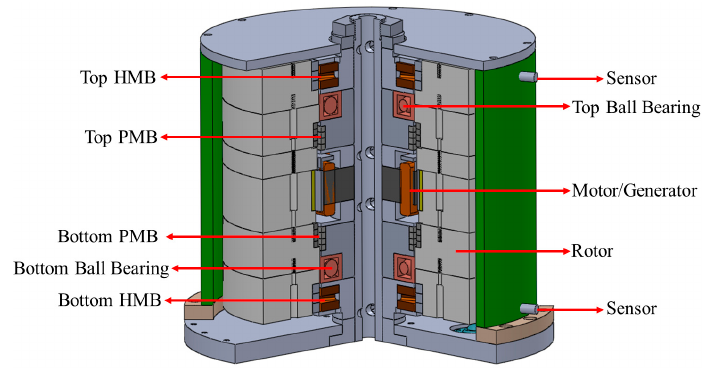
Figure 1. The prototype of flywheel energy storage system (FESS) in this study.